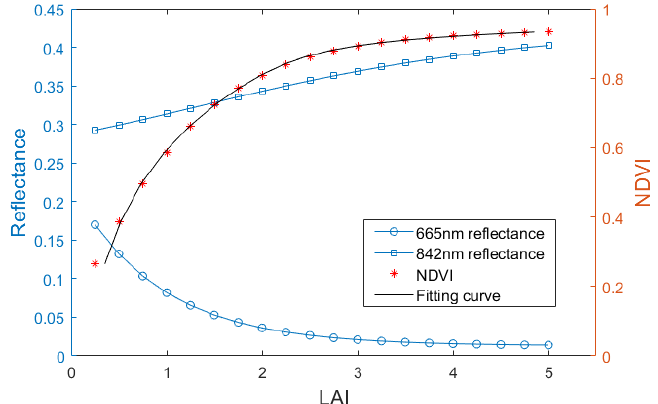
Figure 3. Simulation results under different LAI and the fitting performance between NDVI and